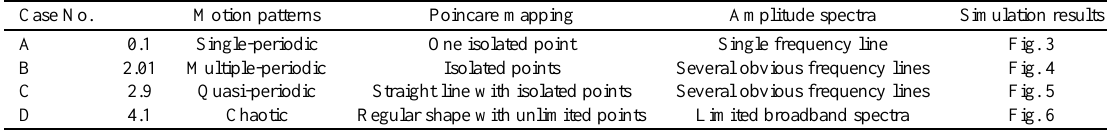
Table 2 The different motions of the two-bar linkage with different friction values